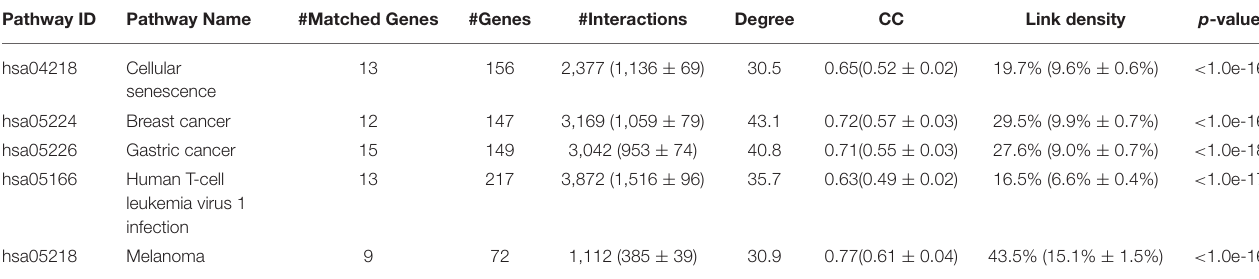
TABLE 2 | Statistics of KEGG pathways related to breast cancer. Pathway